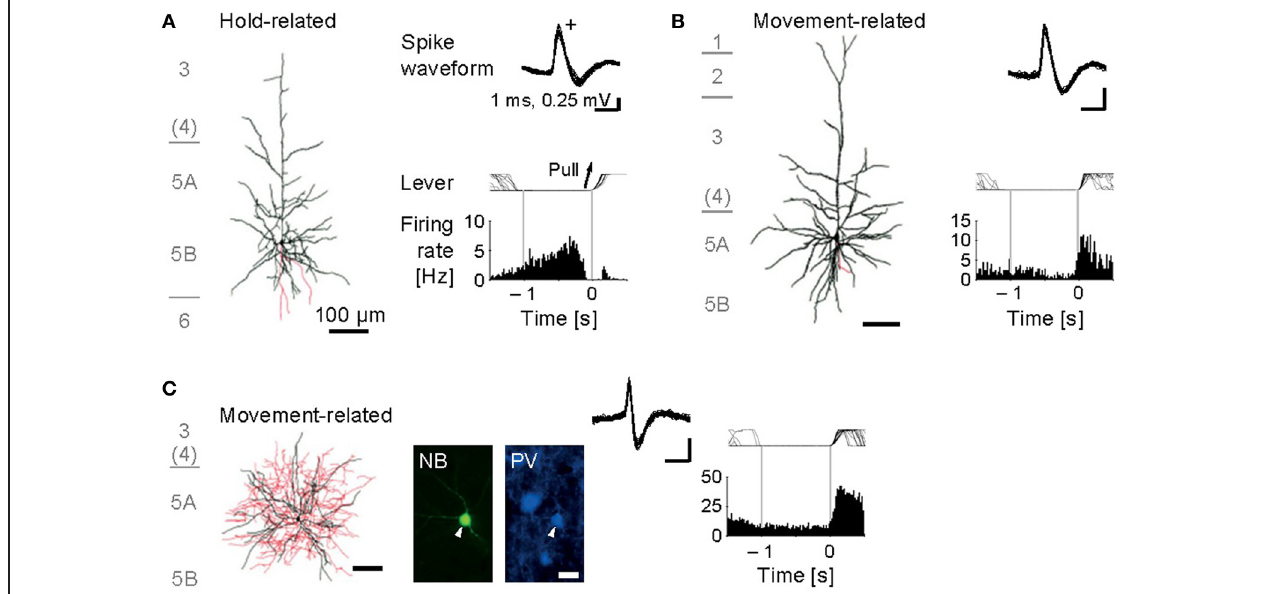
aligned with the onset of lever pull movement (0s). (B) Layer 5 pyramidal cell with movement-related activity. (C) Layer 5 fast-spiking (FS) basket cell with movement-related activity. Bottom, fluorescent images for Neurobiotin (NB) and parvalbumin (PV). [Modified from Isomura et al.